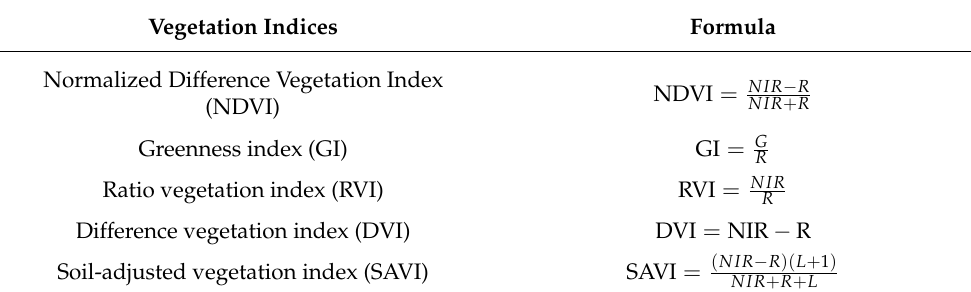
Table A2. Vegetation indices list. Vegetation Indices